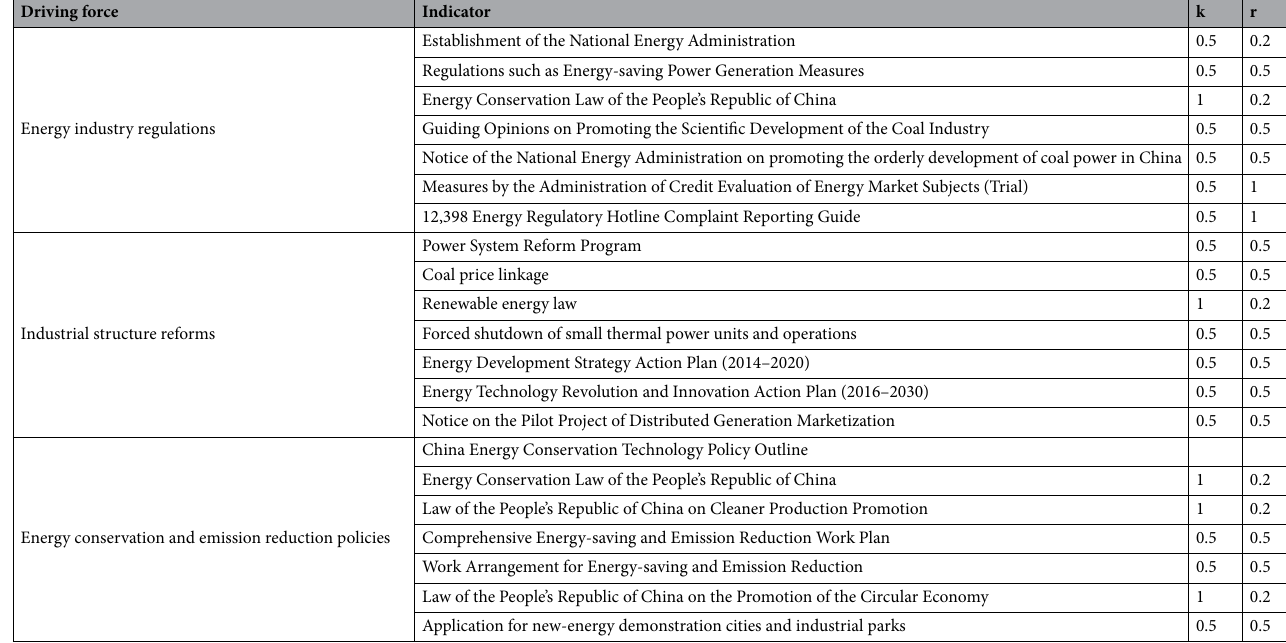
Table 3. Value of k and r for each policy.